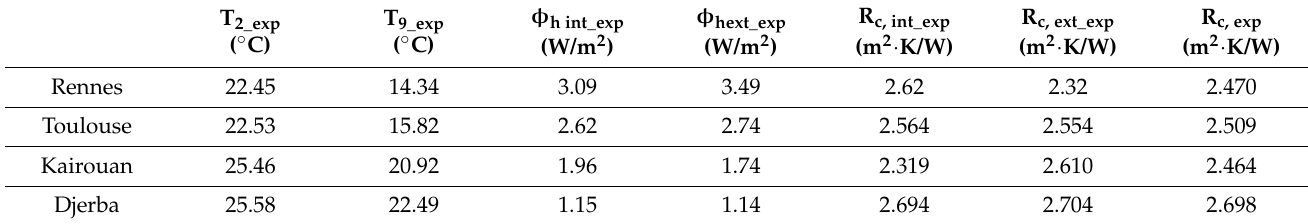
Table 4. Experimental heat fluxes and R c values at the end of the stabilization phase.